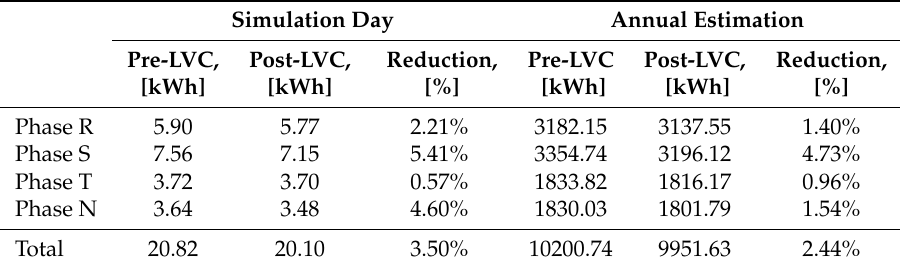
Figure 24. Control action. Generator connected to node 27 (2). Table 6. Power losses, with and without the application of the LVC